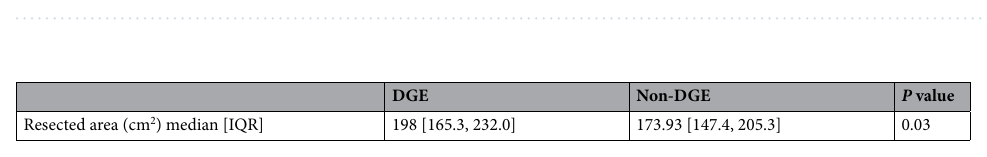
Table 1. Demographic and surgical characteristics of patients. IQR interquartile range, DGE delayed gastric emptying.